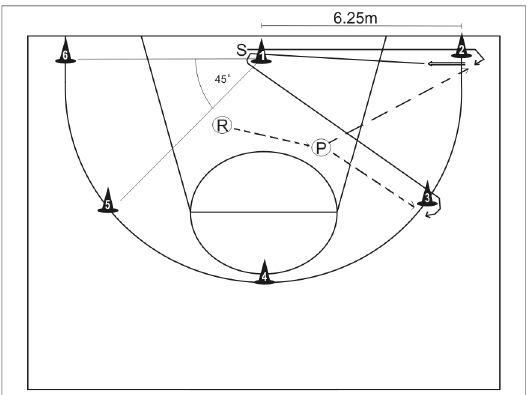
Figure 3. The dynamic 60-second two-point shooting test (S2P60) Legend. R = rebounder, P = passer, S = shooter/testee.